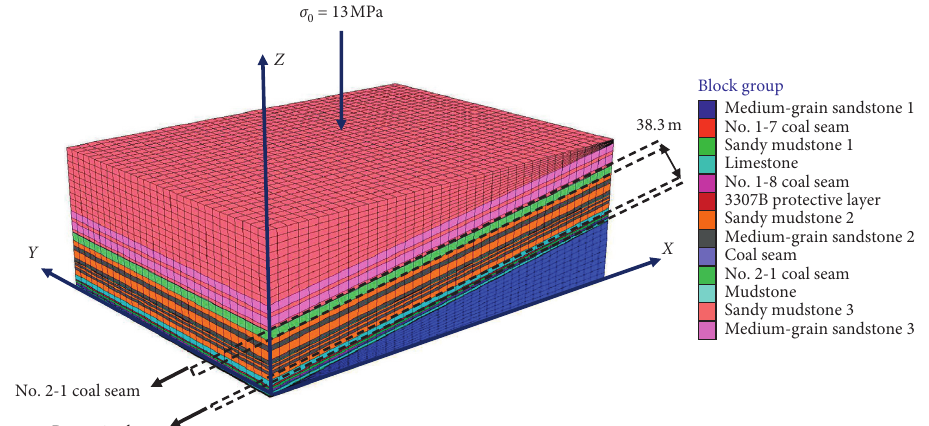
Figure 3: Numerical